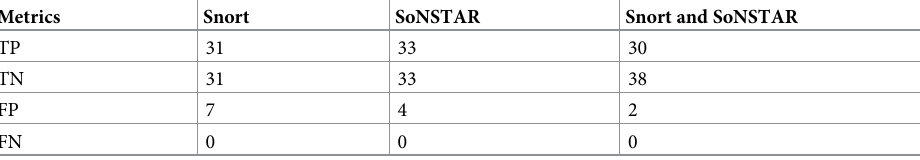
Table 4. TP, TN, FP and